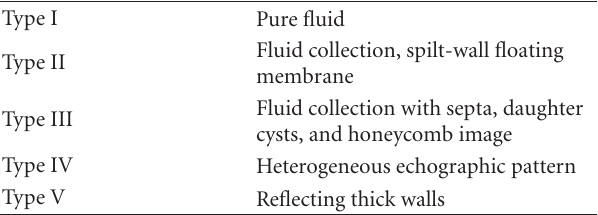
Figure 2: Trocar placement.